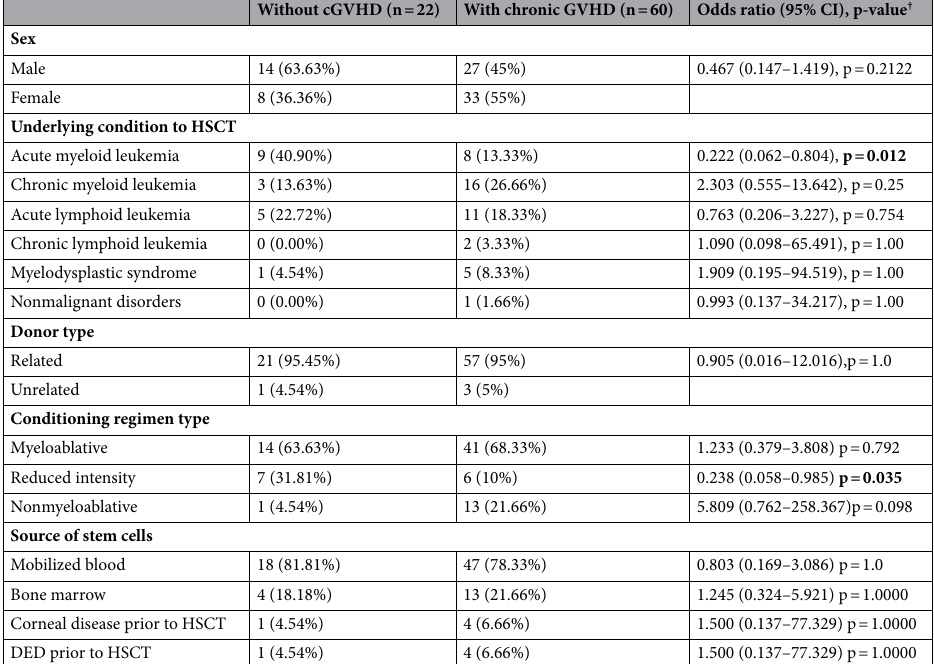
Table 1. Demographics data according to Chronic GVHD history. Data expressed as mean ± standard deviation (median) or frequency. † Chi-square test; Odds Ratios of presenting cGVHD regarding different demographic characteristics; HSCT: Hematopoietic stem cell transplantation; GVHD: Graft-versus-host disease; DED: Dry eye disease; 95% CI: 95% Confidence interval. Significant values are in [bold].